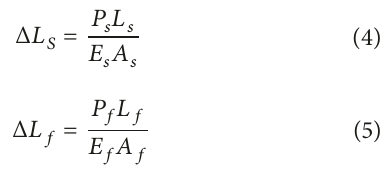
Figure 3: Diagrammatic sketch of the packaged FBG sensor.